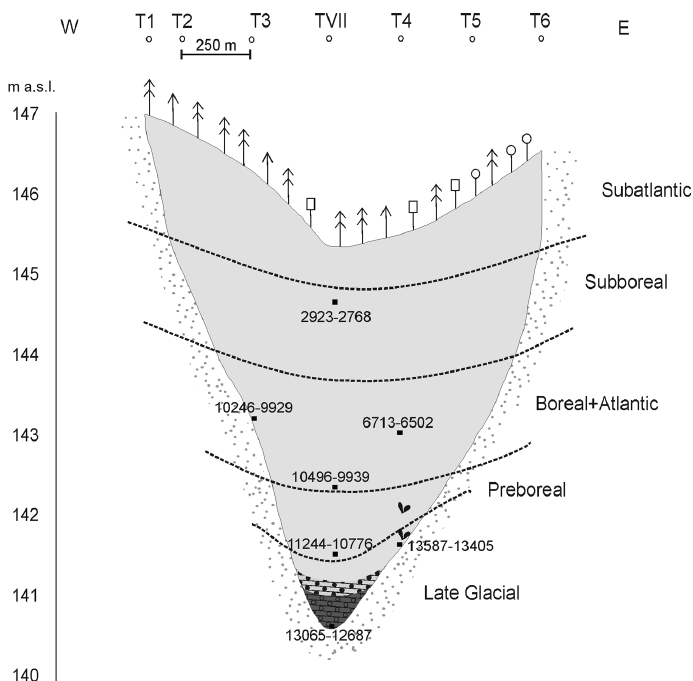
Fig. 5. Transversal cross section of the Tabo ł y mire deposit. For explanations see Fig.